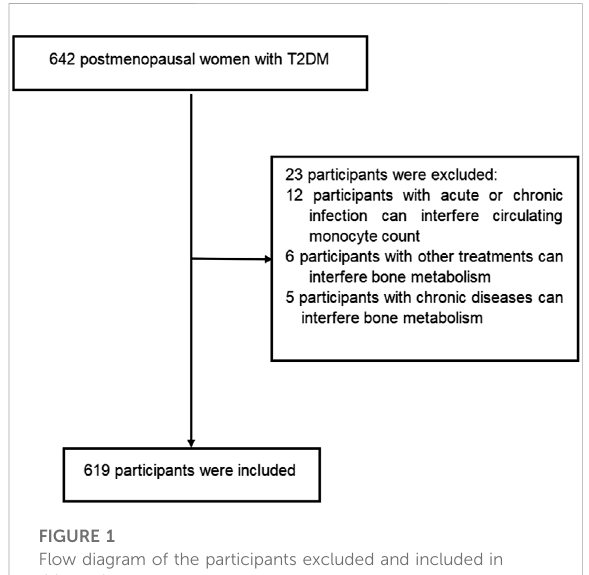
FIGURE 1 Flow diagram of the participants excluded and included in this study.